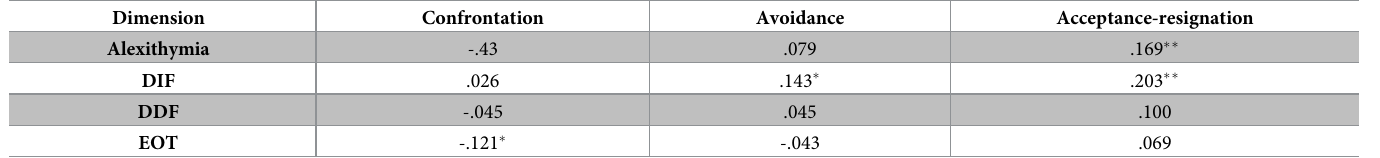
Table 4. Correlation analysis of alexithymia and medical coping modes among patients treated with IVF-ET (r).